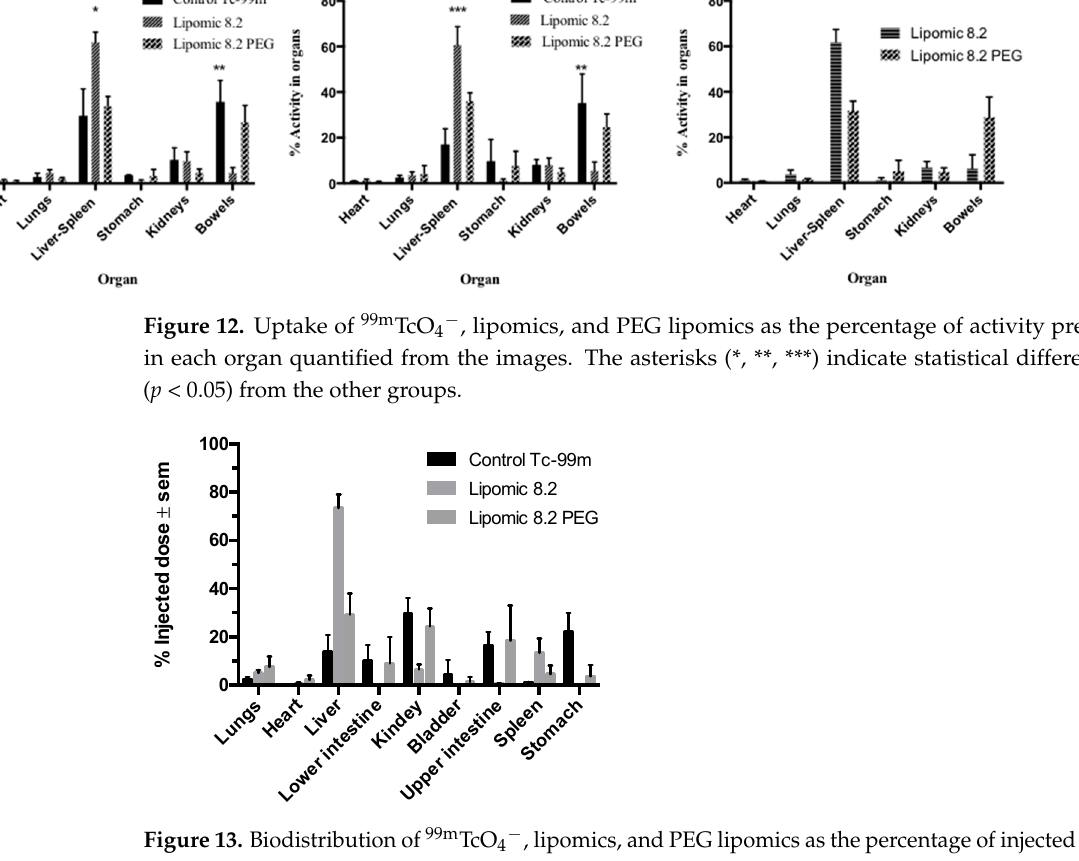
Figure 11. Representative SPECT/CT images of the PEG lipomics’ biodistribution at 1, 3, and 6 h after injection in healthy rats. Images are from the same rat.